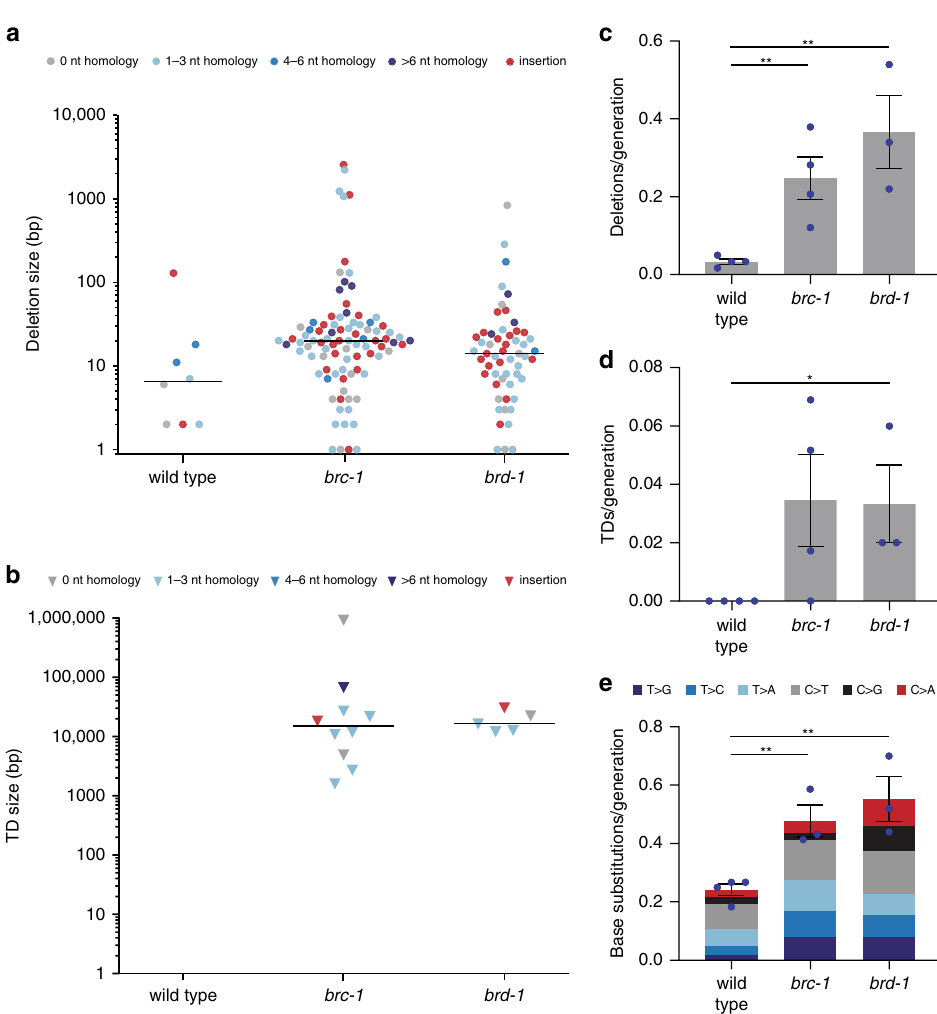
Fig. 1 brc-1 and brd-1 -de fi cient nematodes accumulate mutations in their genomes. a Size and junction representation of deletions that were obtained in wild-type ( n = 4), brc-1 ( n = 6) and brd-1 ( n = 3) mutant animals. Deletions without homology are marked in grey, deletions with homology are marked in blue. Increasing homology size is depicted by increased colour intensity. Deletions with insertions are marked in red. The median deletion sizes are indicated by horizontal lines. b Size and junction representation of tandem duplication (TD) that were obtained in wild-type, brc-1 and brd-1 mutant animals. TDs without homology are shown in grey, TDs with homology are marked in blue. Increasing homology size is depicted by increased colour intensity. TDs with insertions are marked in red. The median TD sizes are indicated by horizontal lines. c Quanti fi cation of the average rate of deletions per generation in animals of different genotypes. The rate is de fi ned as the number of deletions divided by the number of propagated generations per animal. The rate per strain is represented in blue dots. Two-tailed t -tests were used to determine statistical signi fi cance (* P < 0.05, ** P < 0.01). d Quanti fi cation of the average rate of TDs per generation in animals of different genotypes. The rate is de fi ned as the number of TDs divided by the number of propagated generations per animal. The rate per strain is represented in blue dots. Two-tailed t -tests were used to determine statistical signi fi cance (* P < 0.05, ** P < 0.01). e A representation of base substitution type and the average rate of base substitutions per generation in animals of different genotypes. The different types of base substitutions are labelled with different colours. The rate is de fi ned as the number of base substitutions divided by the number of propagated generations per animal. The rate per strain is represented in blue dots. Two-tailed t -tests were used to determine statistical signi fi cance (* P < 0.05, ** P < 0.01). Error bars represent SEM. Wild type: n = 4 of 60 generations, brc-1: n = 6 of 58 generations, brd-1: n = 3 of 50